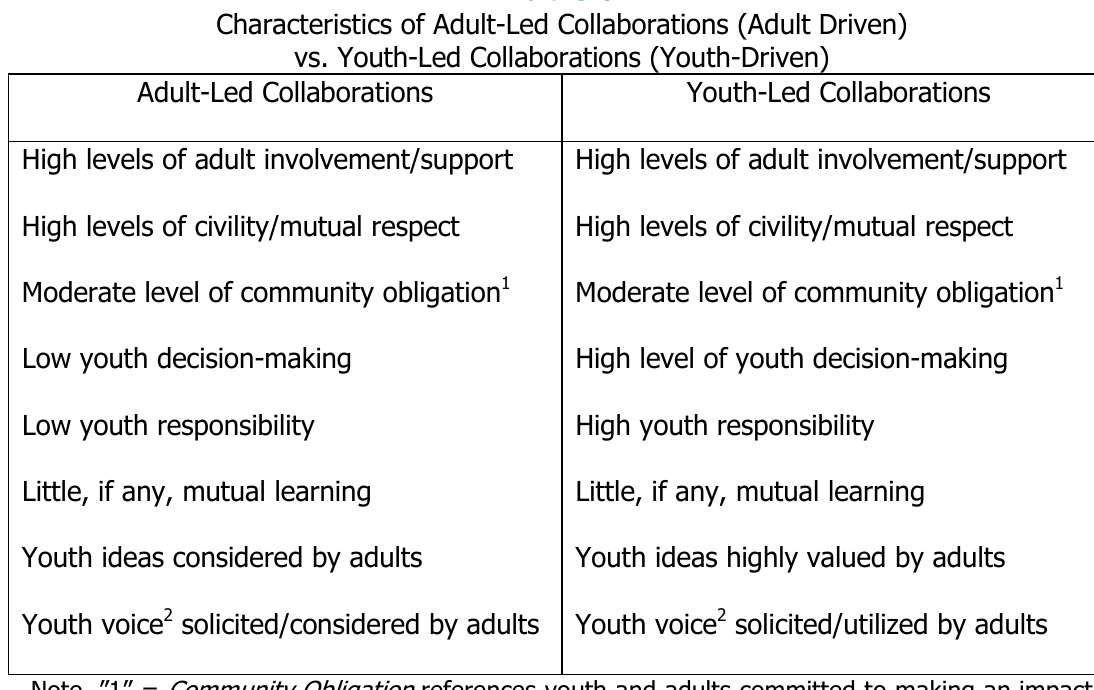
Characteristics of Adult-Led Collaborations (Adult Driven) vs. Youth-Led Collaborations (Youth-Driven) Adult-Led Collaborations Youth-Led